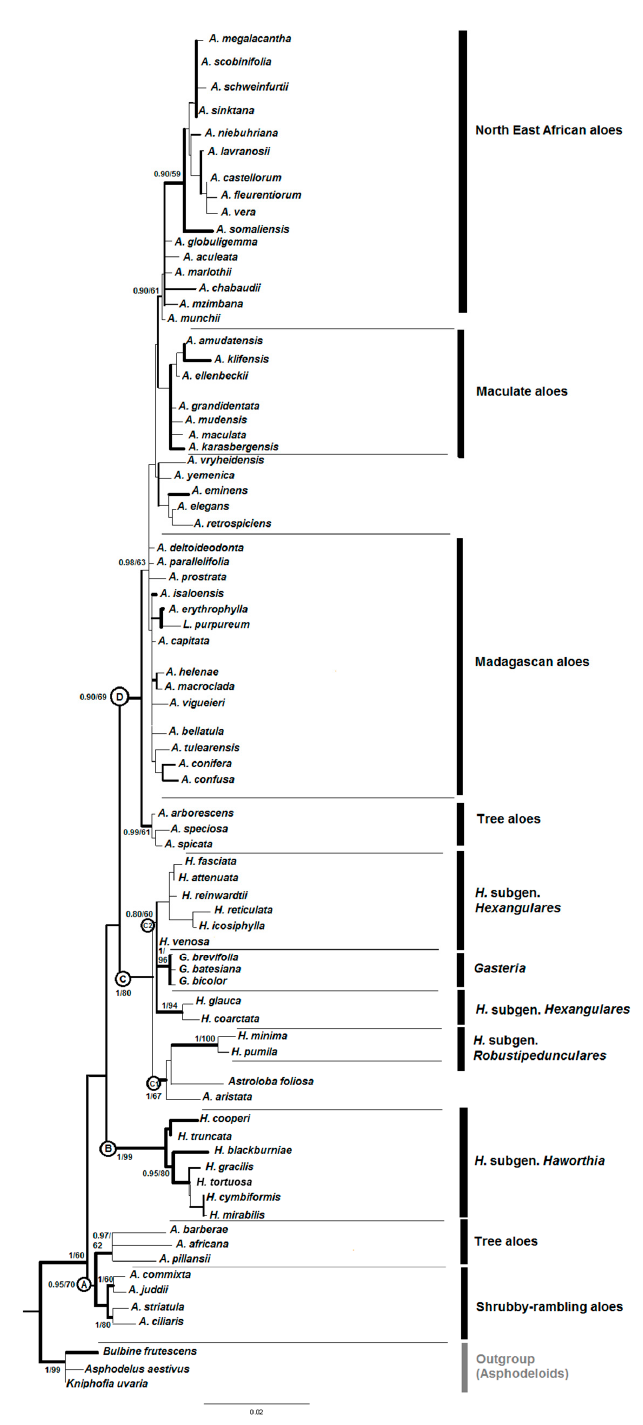
Figure 1. Phylogeny reconstruction of aloes using ML. Numbers at nodes in the ML phylogram refer to posterior probability values from MrBayes and ML bootstrap analyses. The branches in bold indicate a Bayesian posterior probability >0.95. Major lineages are highlighted by the letters A to D: (A) Shrubby and Tree aloes, (B) Haworthia subgen. Haworthia , (C) Haworthioids, (C1) Haworthia subgen. Robustipedunculares , Astroloba and Aloe aristata , (C2) Haworthia subgen. Hexangulares and Gasteria , (D) True aloes and Lomatophyllum .